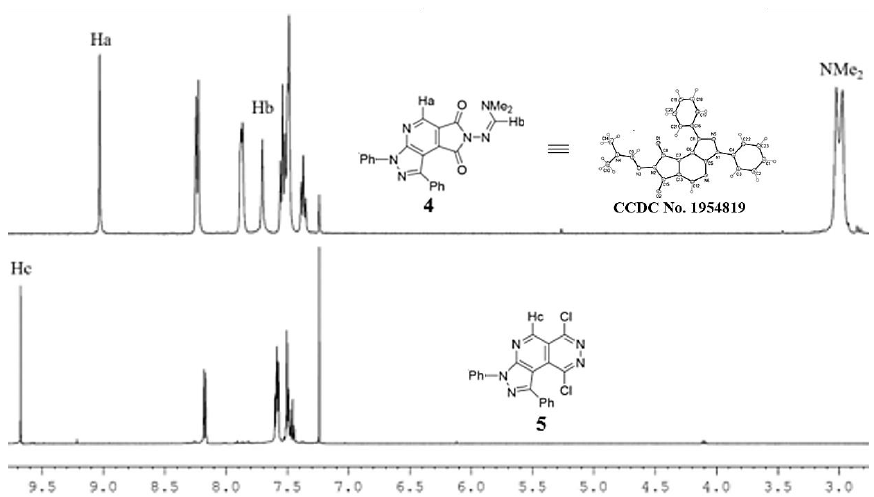
Figure 3. 1 H NMR spectra of 7-amidination product 4 and dichloropyridazine